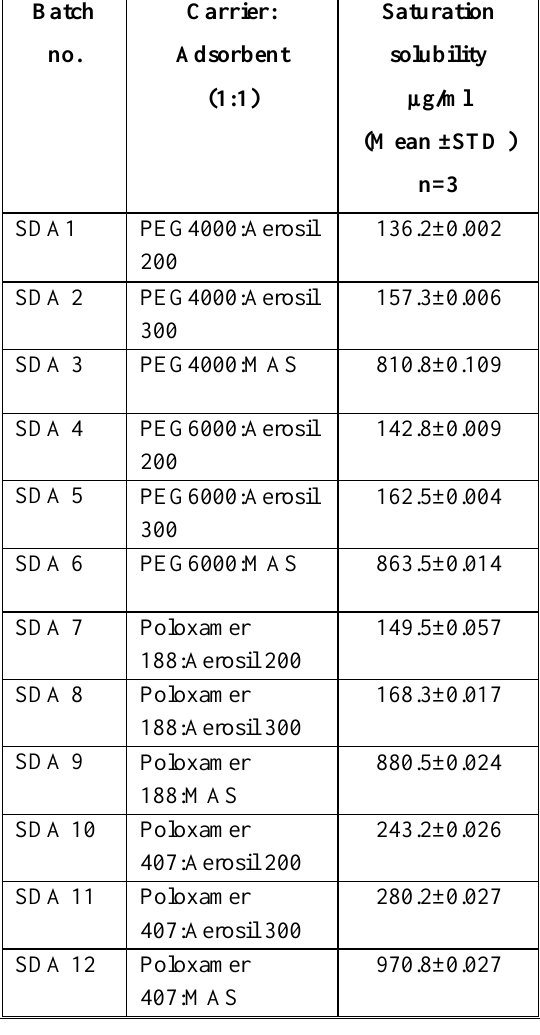
Table 4. The solubility of ATR SDAs prepared with different adsorbents with drug : carrier: adsorbent ratio 1:1:1 in distilled water at